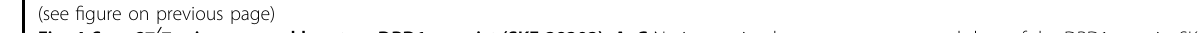
Fig. 4 Sorcs2 − / − mice respond less to a DRD1 agonist (SKF-38393). A , C No interaction between genotype and dose of the DRD1 agonist SKF- 38393 on locomotor activity ( p > 0.3, two-way ANOVA) in neither habituated nor non-habituated mice ( p > 0.3 and p > 0.09, respectively, two-way ANOVA), B , D while a signi fi cant interaction between dose of SKF-38393 and genotype on rearing was observed in both habituated and non- habituated mice ( p < 0.03 for both setups, two-way ANOVA) was observed. Post hoc analysis showed that Sorcs2 − / − mice require higher doses of SKF-38393 to induce a response compared to Wt mice. E Wt and Sorcs2 − / − mice responded similar to cocaine-induced activity ( p > 0.5, two-way ANOVA), F while, a signi fi cant interaction between cocaine dose and genotype on rearing was observed ( p < 0.04, two-way ANOVA). G Wt and Sorcs2 − / − mice showed similar activity response to methylphenidate ( p > 0.2, two-way ANOVA). Data are presented as mean activity count/rearing for one hour per mouse ± S.E.M, except for the methylphenidate data, where results are given as mean distance in meter ± S.E.M ( n = 6 – 12 mice per group). Above the graph, it is stated if the mice were habituated or not to the test-cage prior to drug treatment. The * symbol indicates a signi fi cant difference between the two genotypes, while # and § indicate signi fi cant differences between the treated group and vehicle group in Wt and Sorcs2 − / − mice, respectively. *, § and # p < 0.05; **, ## and §§ p < 0.01; *** and §§§ p < 0.001; #### and §§§§ p <